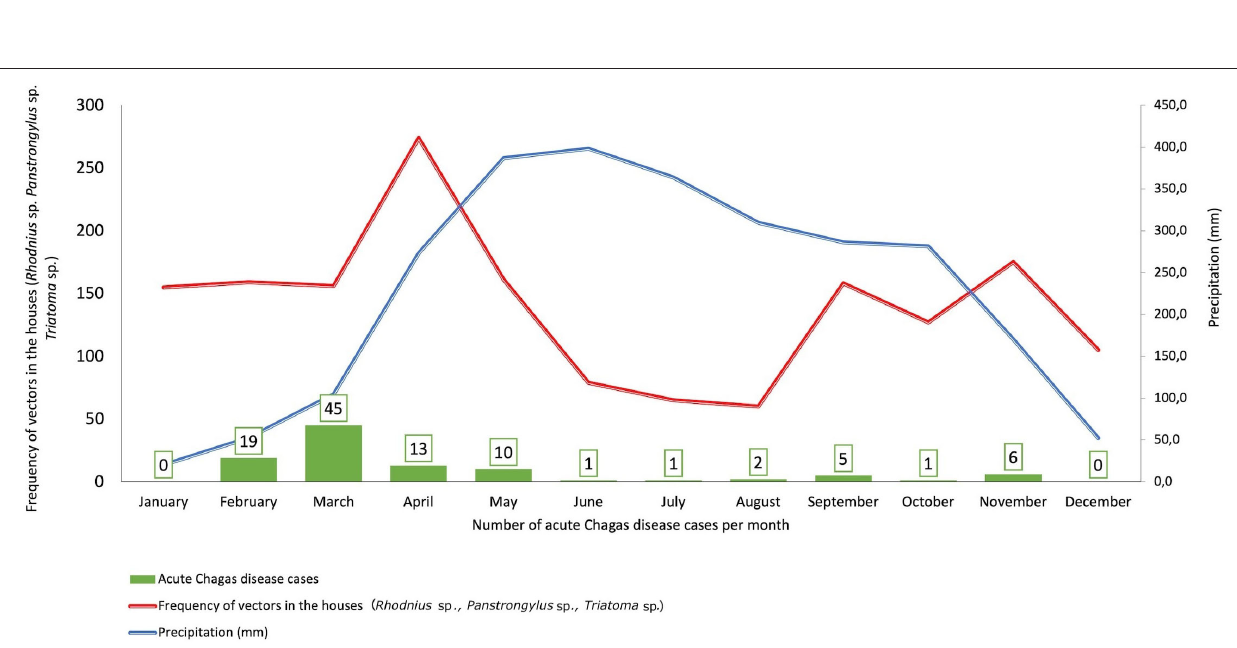
Frontiers in Medicine |